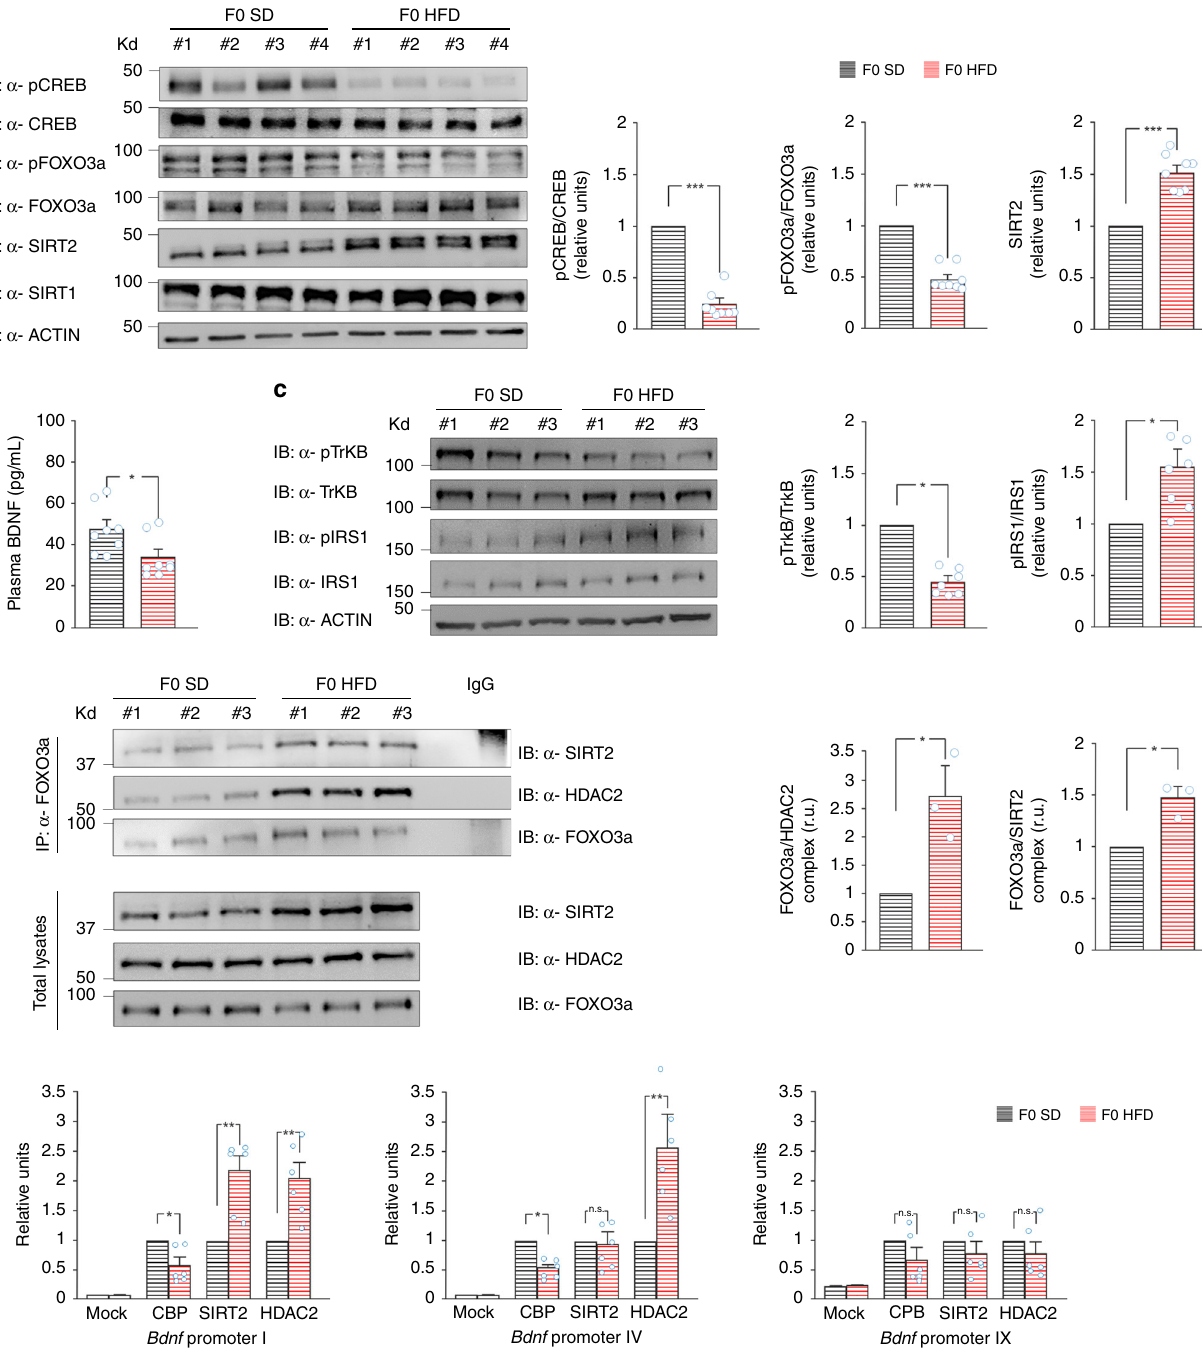
Fig. 6 HFD affects HAT/HDAC recruitment on Bdnf promoters in ovaries. a Immunoblots and bar graphs of both CREB Ser133 and FOXO3a Ser256 phosphorylation and sirtuin expression in the ovaries from F0 SD and F0 HFD female mice ( n = 8 per group; statistics by unpaired Student ’ s t test). Samples were harvested from two independent experiments. b BDNF plasma levels of F0 SD and F0 HFD female mice measured by ELISA performed in duplicate ( n = 8 mice per group; statistics by unpaired Student ’ s t test). c Immunoblots (left) and bar graphs (right) of both TrkB Tyr816 and IRS1 Ser612 phosphorylation in the ovaries from F0 SD and F0 HFD mothers ( n = 7 per group; statistics by Mann – Whitney test). Samples were harvested from two independent experiments. d Immunoblots (left) and densitometry (right) of FOXO3a interaction with both SIRT2 (top) and HDAC2 (middle) in the ovaries from F0 SD and F0 HFD mice ( n = 3 per group; statistics by Mann – Whitney test). At the bottom, tissue lysates probed with α -SIRT2, α -HDAC2, and α - FOXO3a. e ChIP assays of CBP, SIRT2, and HDAC2 binding on the promoters I, IV, and IX of Bdnf gene in the gonads of F0 SD and F0 HFD female mice. Data represent mean values obtained from six mice for each group; qPCR experiments were performed in triplicate (statistics by Mann – Whitney test). Data are expressed as mean ± SEM. Source data are provided as a Source Data fi le. * p < 0.05; ** p < 0.01; *** p < 0.001; n.s. not signi fi